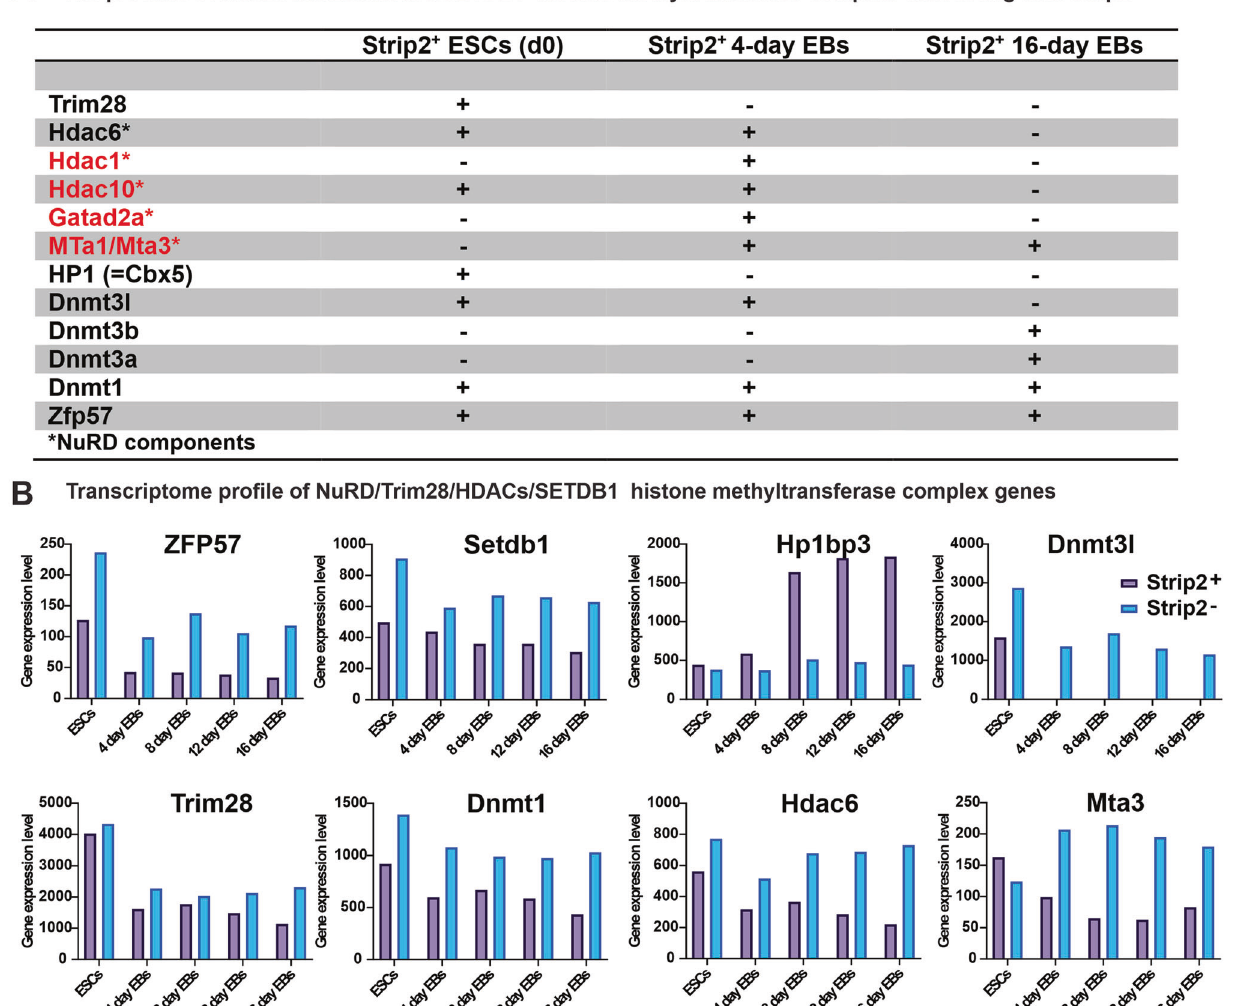
Fig. 5 Transcriptional repression complex: Proteins interacting with Strip2. A List of proteins from nucleosome remodeling and histone deacetylase (NuRD) components interacting with Strip2 during different points of differentiation from day 0 to day 16. B Gene expression pro fi le of transcriptional repression complex genes involved epigenetic